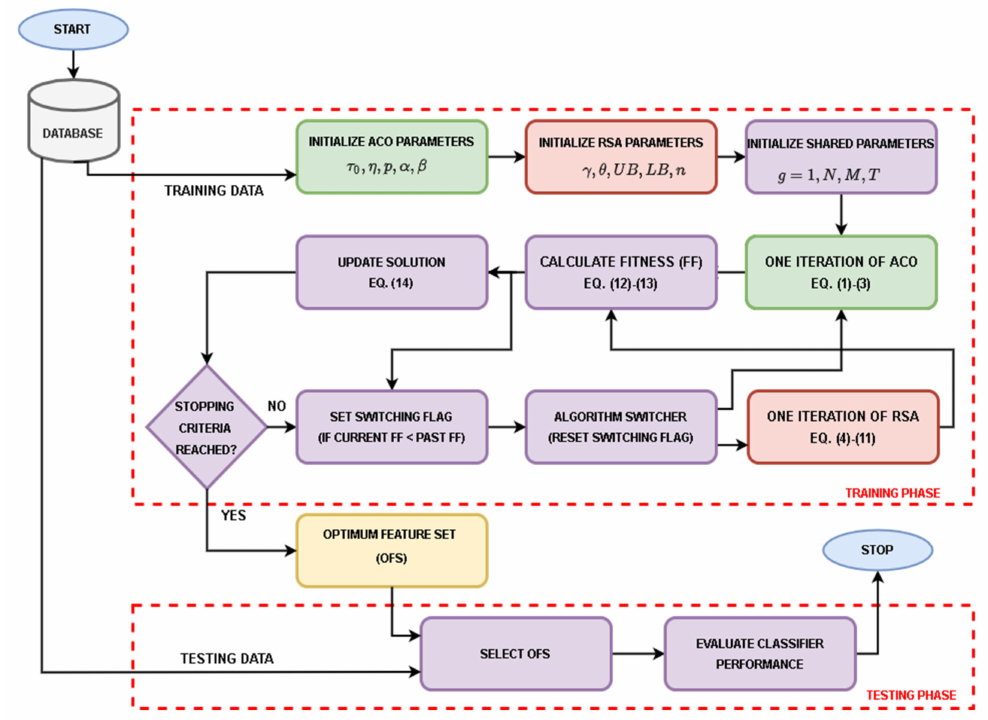
Figure 3. The flow diagram of the ACO-RSA